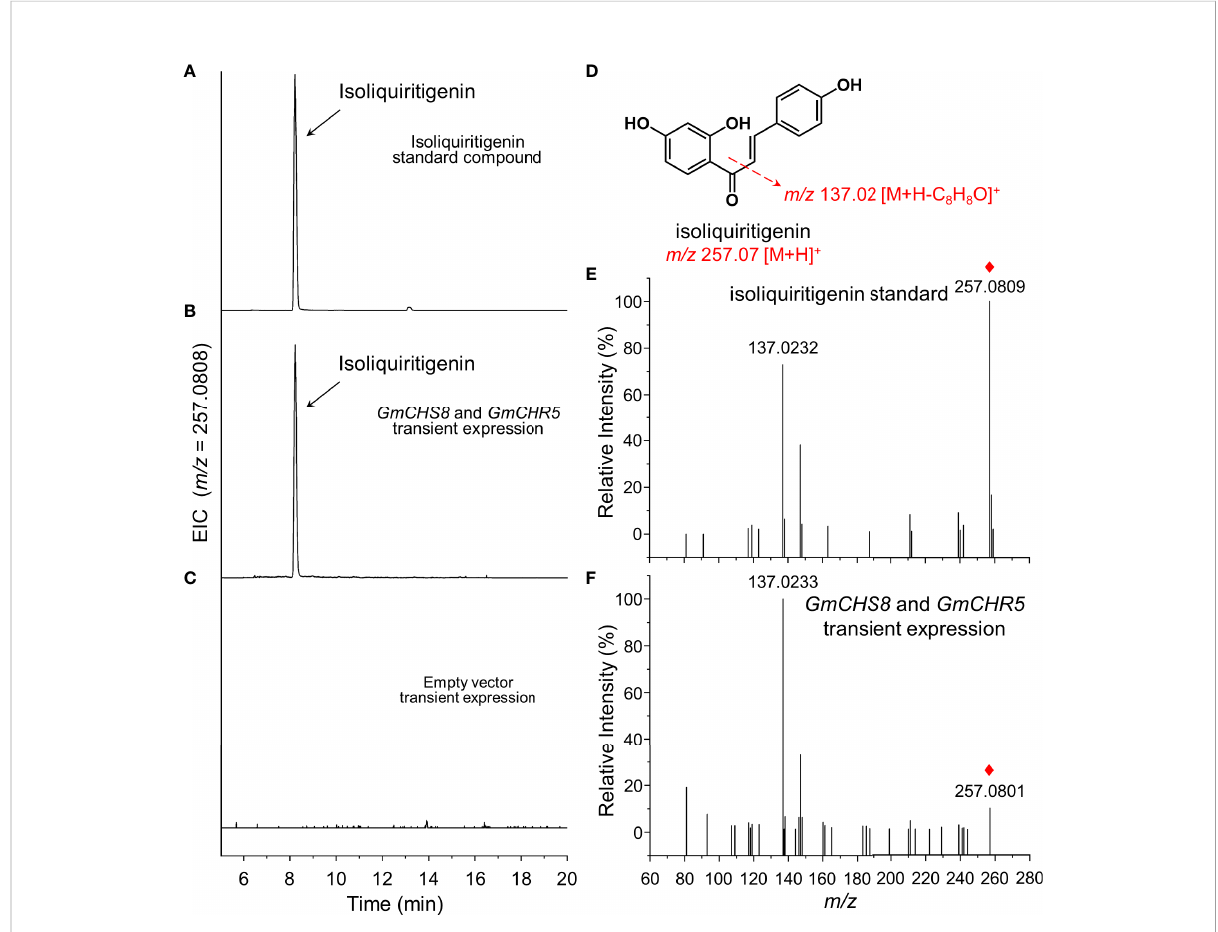
FIGURE 3 Generation of isoliquiritigenin in tobacco by transient expression. GmCHS8 and GmCHR5 was transiently co-expressed in tobacco leaves. Representative extracted ion chromatogram (EIC) of (A) isoliquiritigenin standard, (B) GmCHS8 and GmCHR5 co-expressed samples, and (C) negative control was shown. (D) The structure of isoliquiritigenin and its fragmentation pattern was proposed by dotted arrows. Positive ion modes of MS/MS spectra of (E) isoliquiritigenin standard and (F) GmCHS8 and GmCHR5 co-expressed samples was shown. Red rhombs indicated the precursor ions of